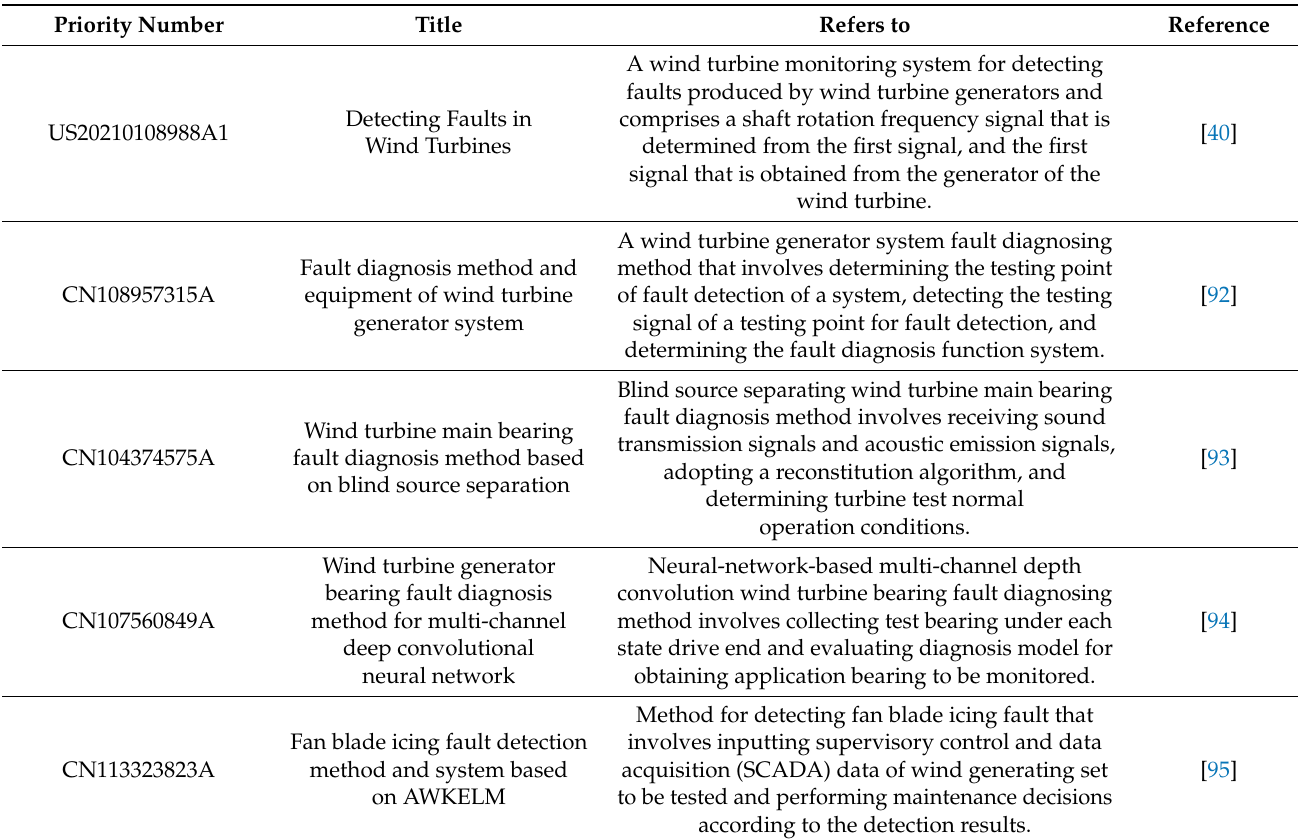
Table 3. Patents documents involving technologies related to fault diagnosis for wind